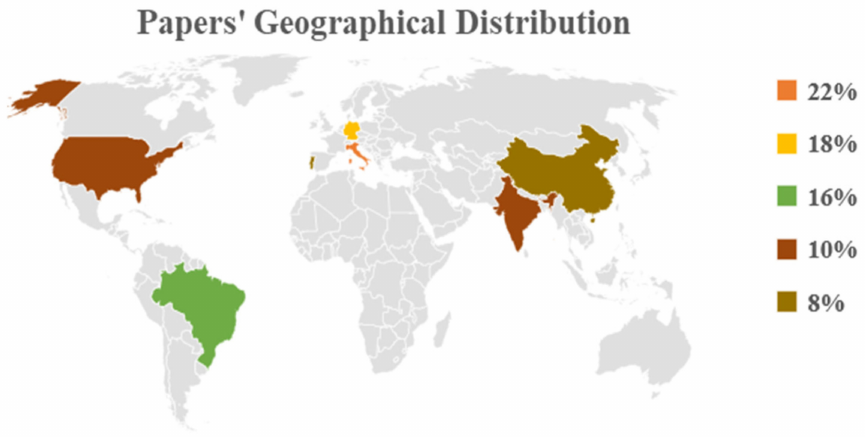
Figure 6. Papers’ geographical distribution.